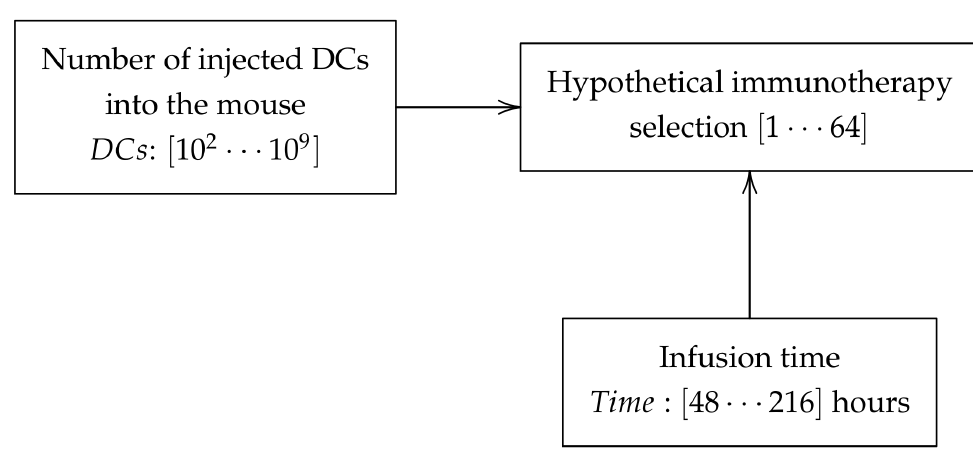
Figure 1. Selection scheme of the hypothetical